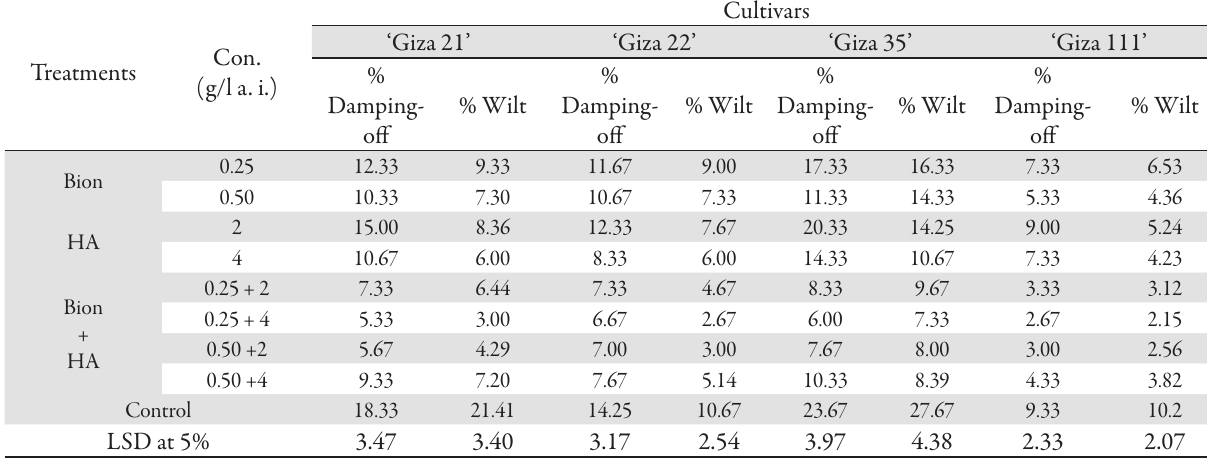
Tab. 3. Effect of BTH and HA on damping-off and wilt diseases of the four soybean cultivars under field conditions in New Valley governorate at summer season 2010